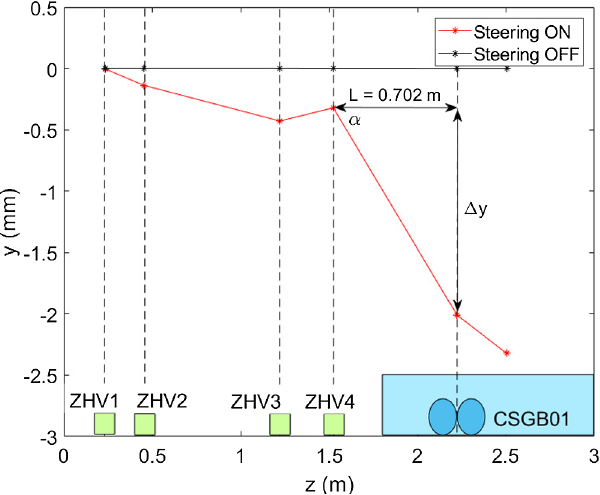
FIG. 19. Influence of the steering coils on the electron beam trajectory. The trajectory is shown on the z - y plane. It is simulated for two cases: when all coils are turned on (dotted-dashed line) and off (solid line), respectively. The total effect of ZHV1 – ZHV4 on the beam trajectory is a vertical offset of Δ y ¼ 1 . 69 mm at the first injector cavity location. The corresponding entry angle is α ¼ 0 . 138 °.